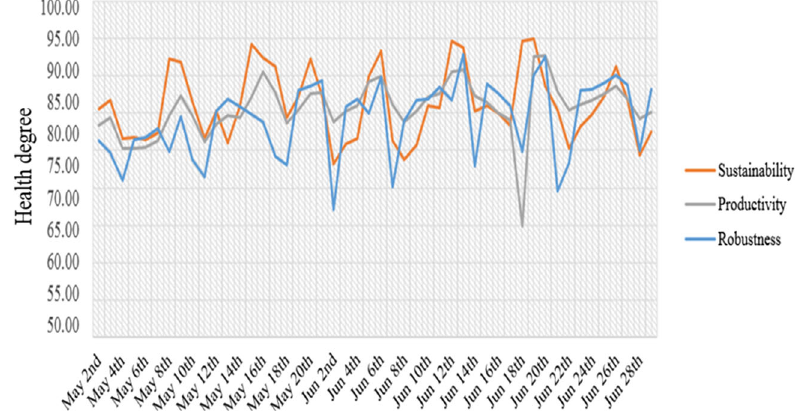
Fig. 7 Scores of robustness, productivity and sustainability of Wuxi ’ s taxi